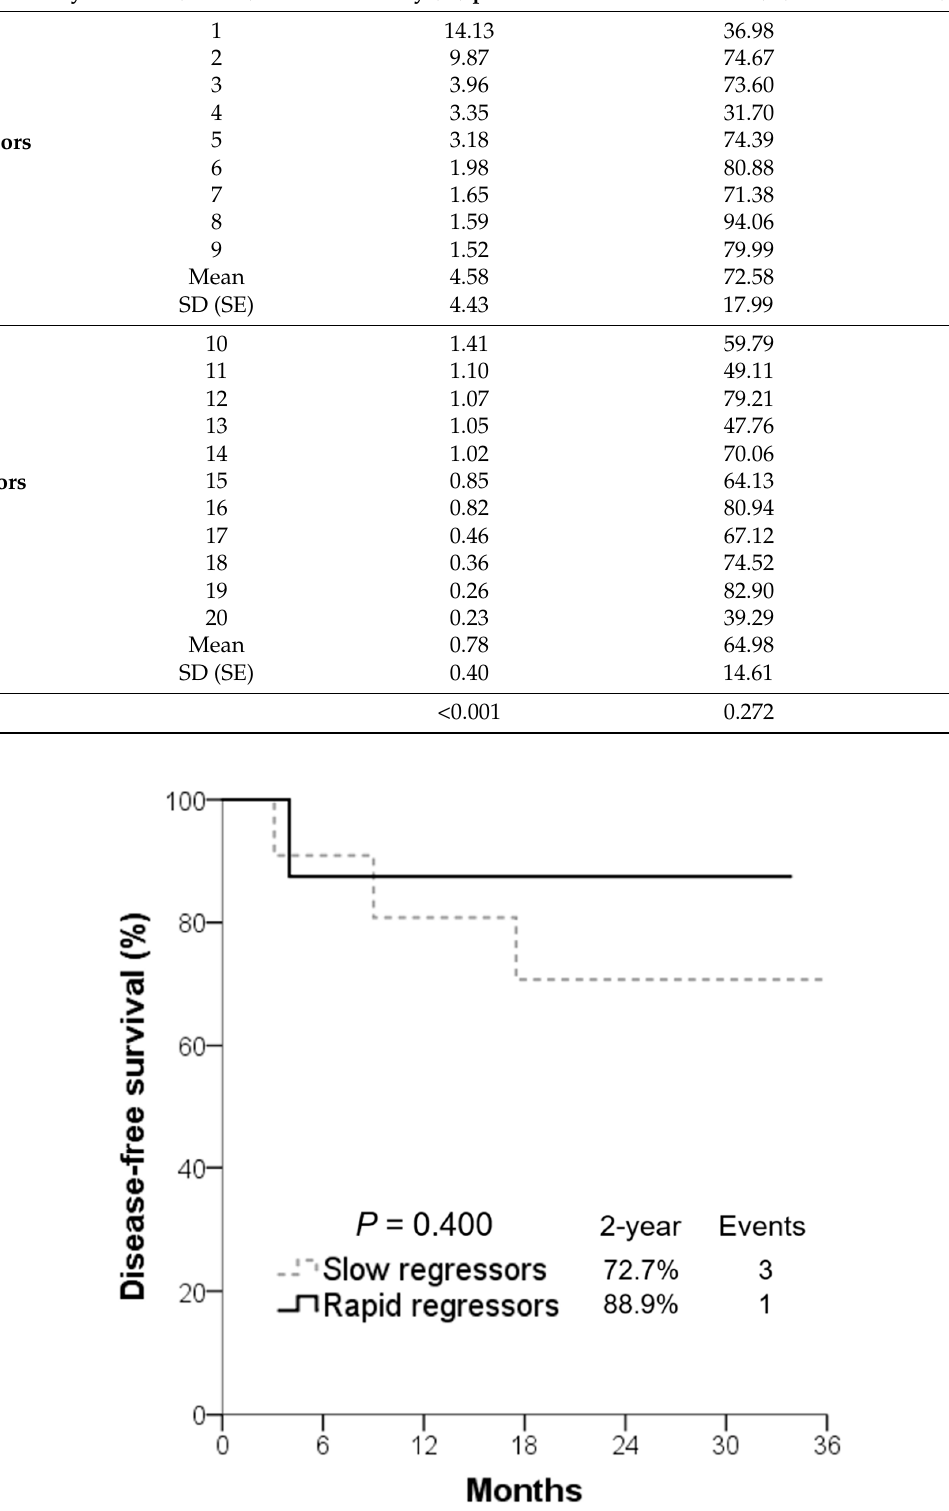
Figure 2. Rapid regressors had numerically superior disease-free survival rate compared to slow regressors.